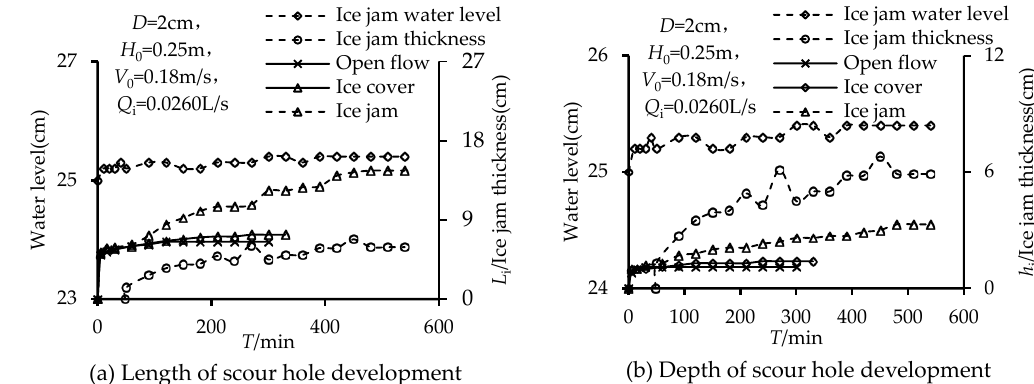
Figure 15. Comparison of the development of a scour hole around a pier under open flow, ice cover and ice jam conditions in Case 1.